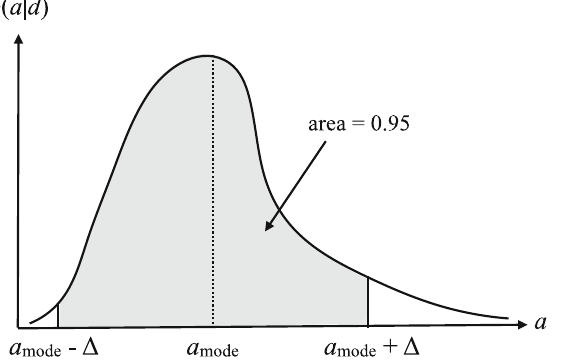
Fig. 8 Definition of a Bayesian credible interval for parameter estimation. Here we construct a symmetric 95% credible interval centered on the mode of the